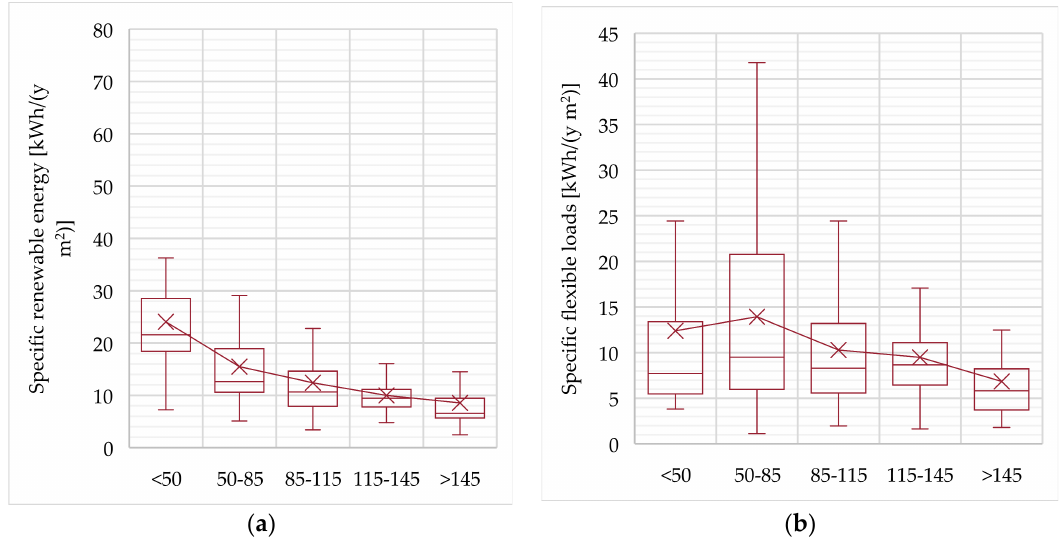
Figure 5. Key performance indicators: ( a ) specific renewable energy; ( b ) specific flexible loads.